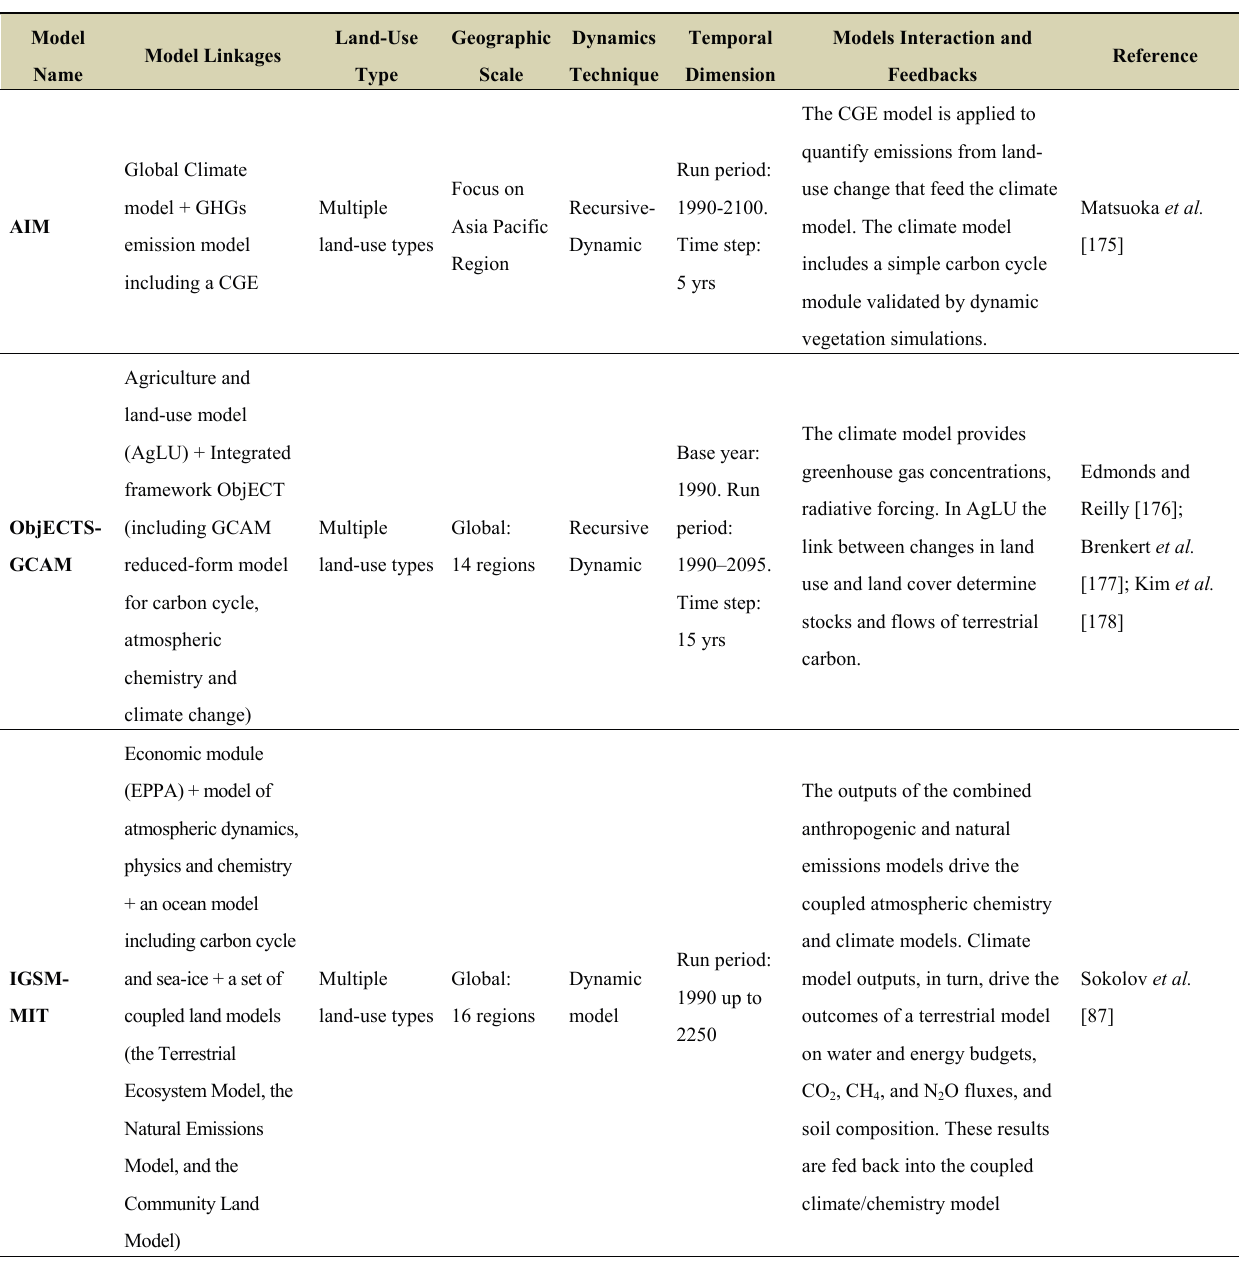
Table 6. Characteristics of some Integrated Assessments linked with reduced form models for carbon cycle and atmospheric